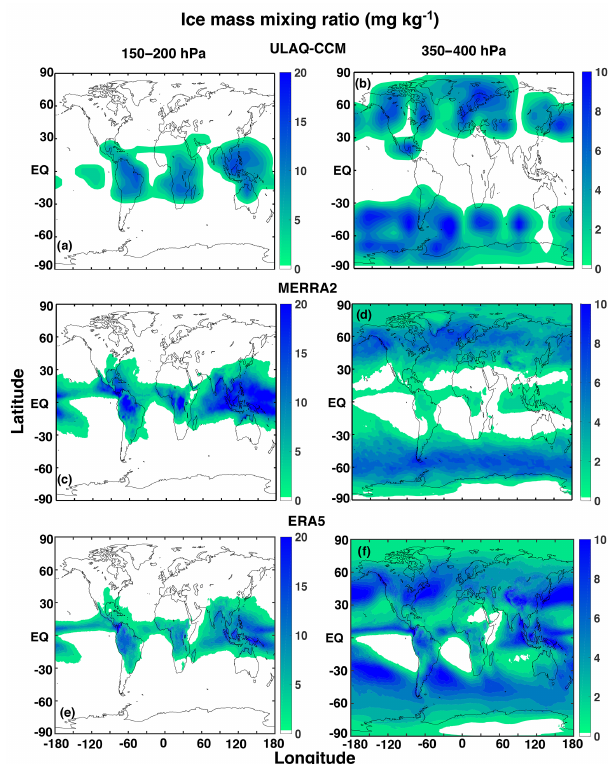
Figure 1. Lat–long maps of the ice mass mixing ratio (mgkg − 1 - air) for pressure layers representative of the tropical (a, c, e) and extratropical (b, d, f) upper troposphere. Panels (a) and (b) are for ULAQ-CCM; panels (c) and (d) are for MERRA-2 data (Bosilovich et al., 2017); panels (e) and (f) are for ERA5 data (Stephens et al., 2000). Time is averaged over the years 2003–2012.